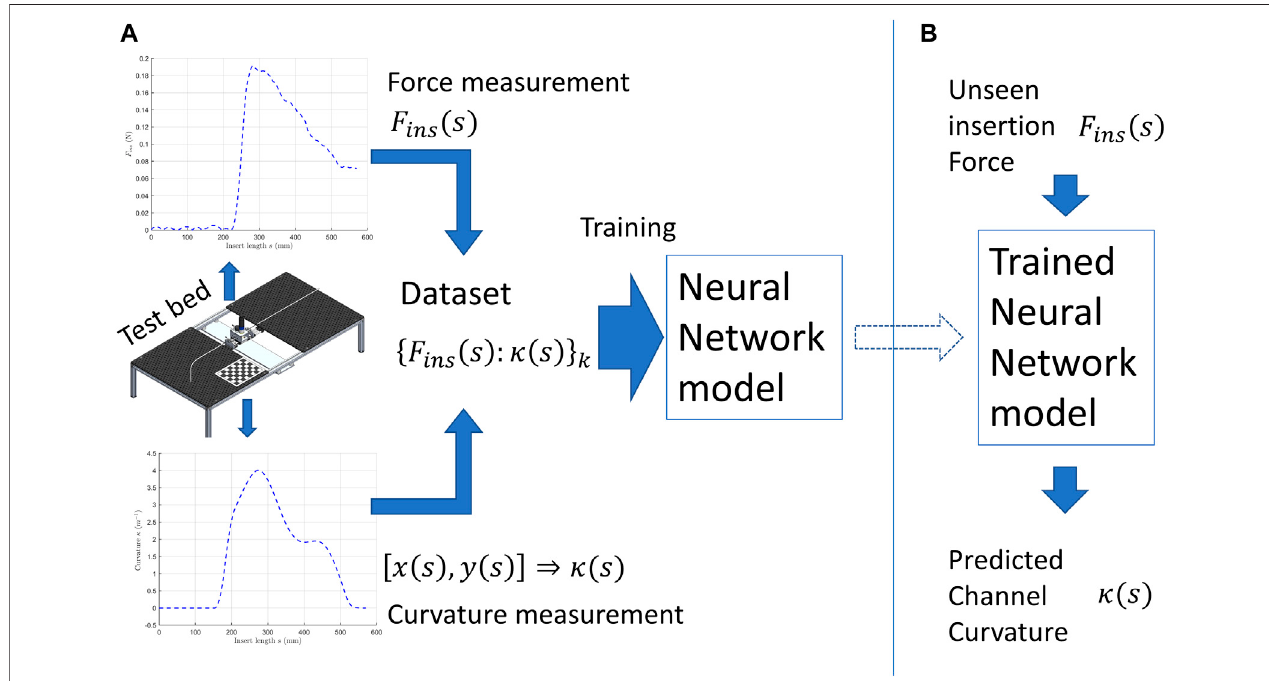
FIGURE 1 | Illustration of the proposed method. (A) data collection and model training. (B) using the model to predict curvature.